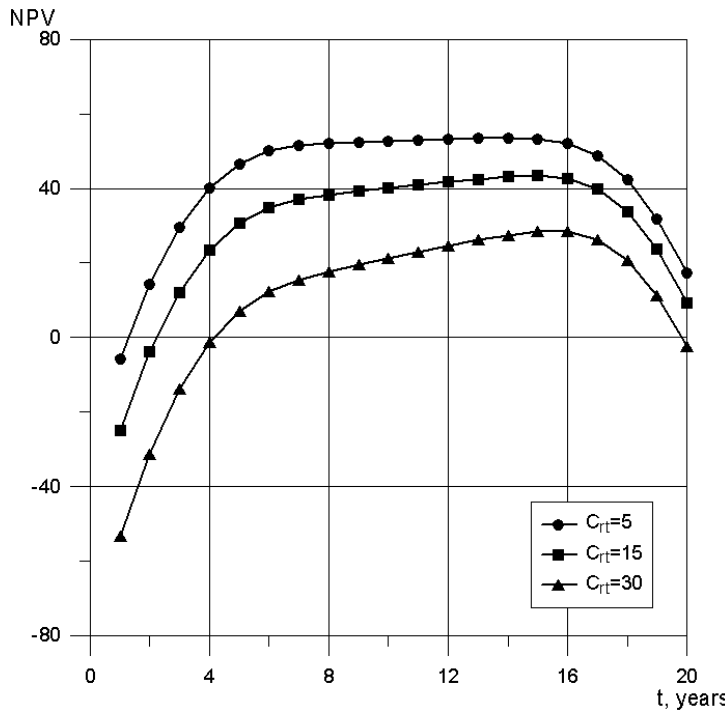
Figure 10. NPV index for 𝑎 0 = 3 mm and 𝑍 0 = 0 .